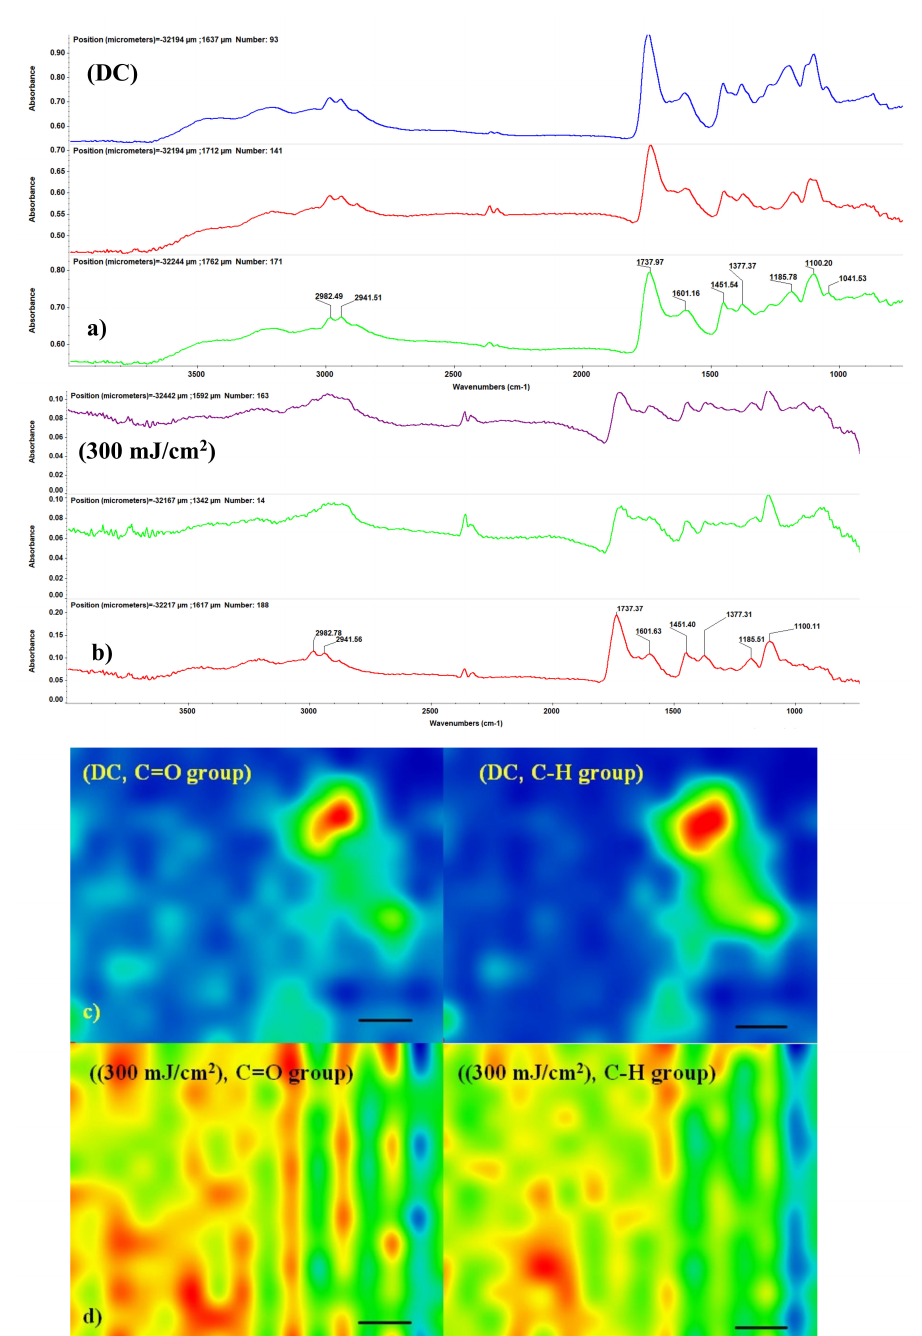
Figure 3. IR spectra of ( a ) drop-cast PLGA–Fe 3 O 4 @AN and ( b ) PLGA–Fe 3 O 4 @AN coatings obtained at 300 mJ / cm 2 ; IR maps of ( c ) drop-cast samples and ( d ) thin coatings (scale bar 50 µ